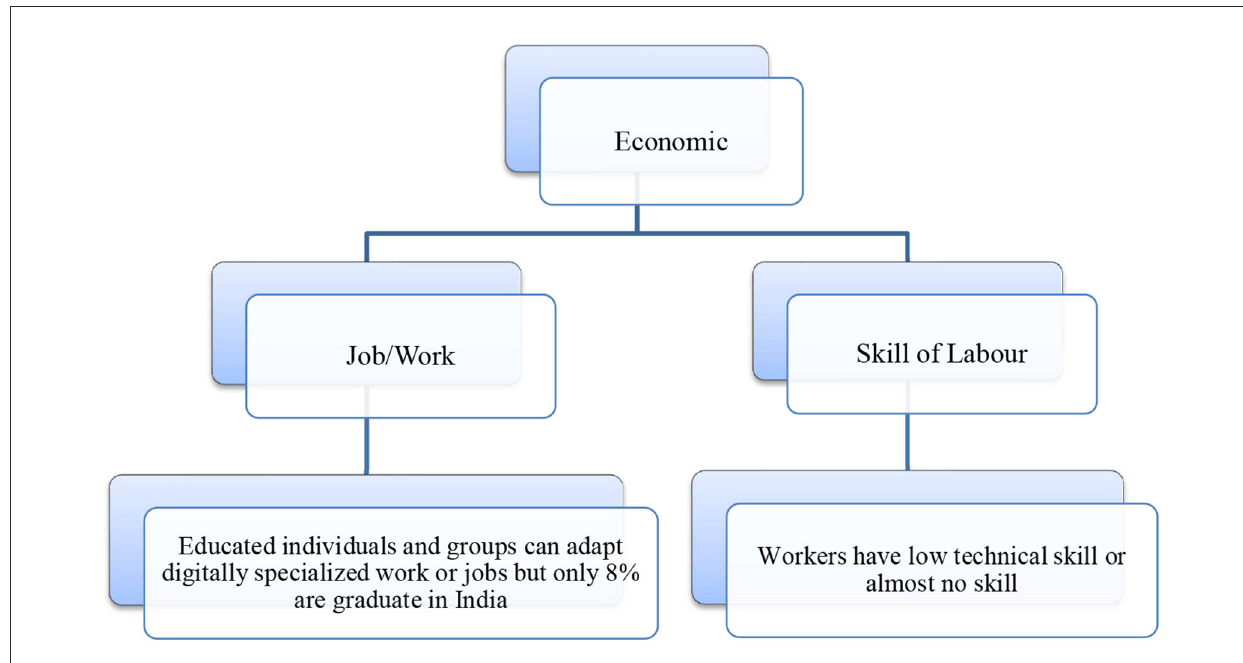
FIGURE3 Economic dimension of the digital divide in India. Source: Census India (2011) & field study conducted in village and city in